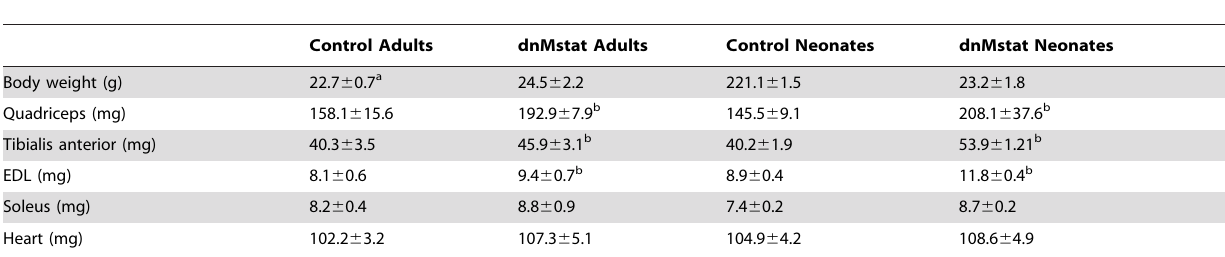
Table 1. Effect of systemic myostatin inhibition on muscle mass in C57 Bl/6